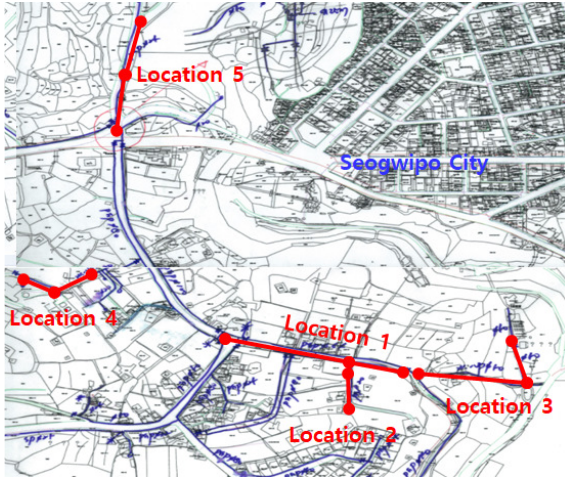
Figure 8. Locations for field